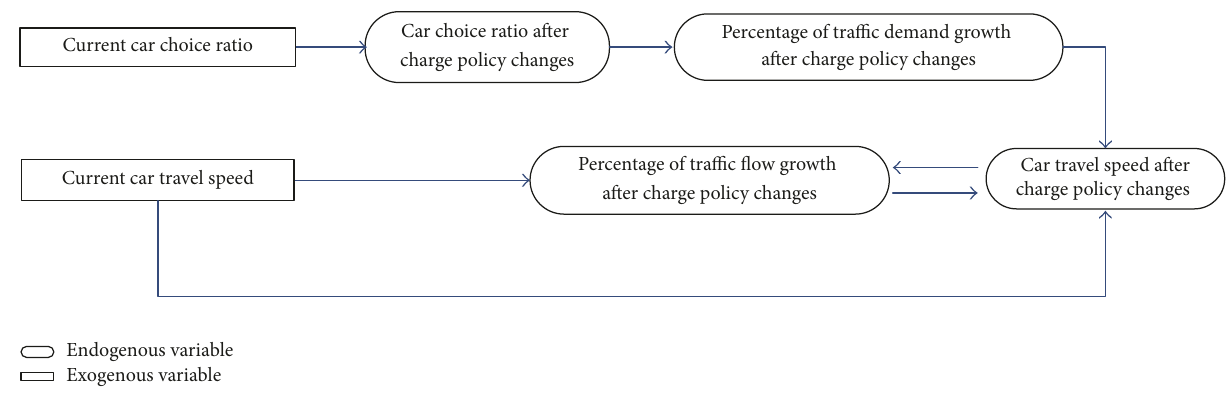
Figure 5: Relation between travel mode distribution and travel speed.